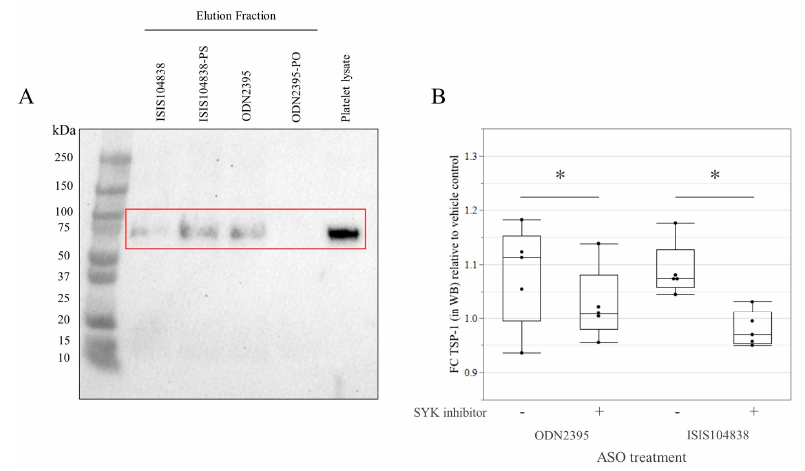
Figure 3. ( A ) Pull-down assay identified GPVI protein as a binding partner for PS-modified ASOs (contained in the red box with the positive control, platelet lysate); representative of Western blot detecting GPVI (n = 3). ( B ) Whole blood (n = 5) pretreated or not with the spleen tyrosine kinase (SYK) inhibitor PRT-060318 (10 µM) before the addition of vehicle (DPBS), or 5 µM ASOs (ODN2395 and ISIS104838). Change in TSP-1 level in the different treatment groups is expressed as fold change (FC) with respect to the vehicle control. * p < 0.05 by linear mixed model with paired Student’s t-test as post hoc for the effect of the SYK inhibitor.